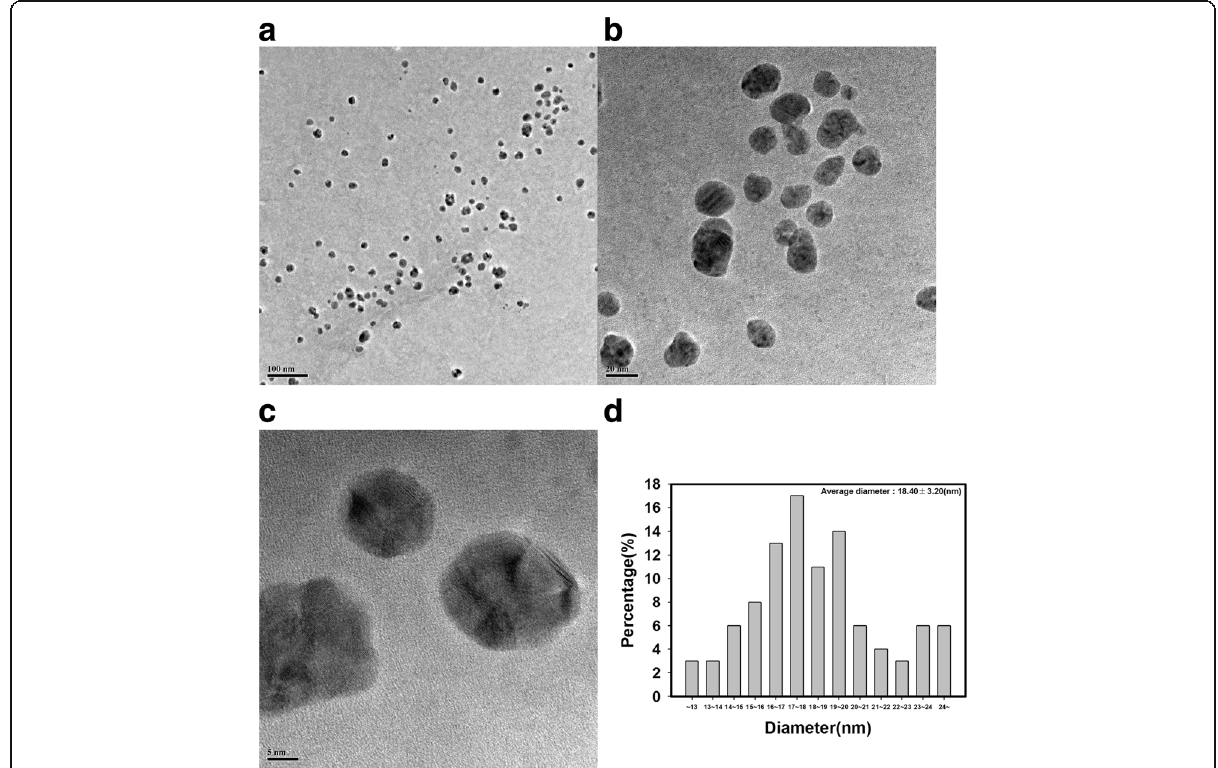
Fig. 4 a – c HR-TEM images and d a size histogram of PD-AgNPs. The scale bars represent a 100 nm, b 20 nm, and c 5